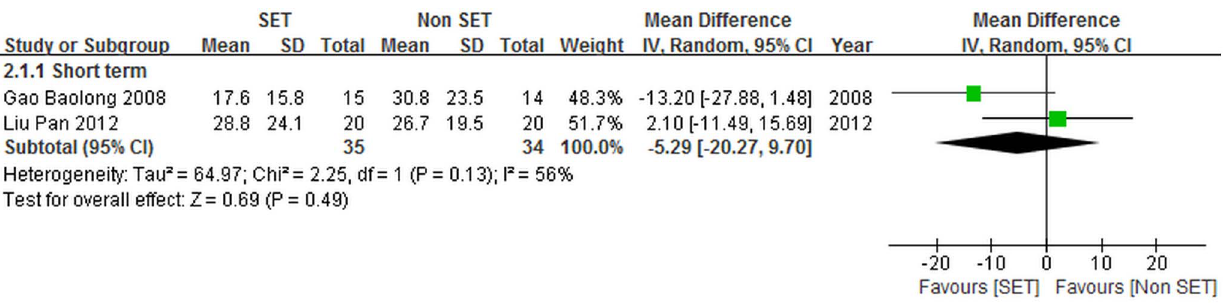
Figure 4. Self-reported pain for sling exercise versus traditional Chinese medical therapies.